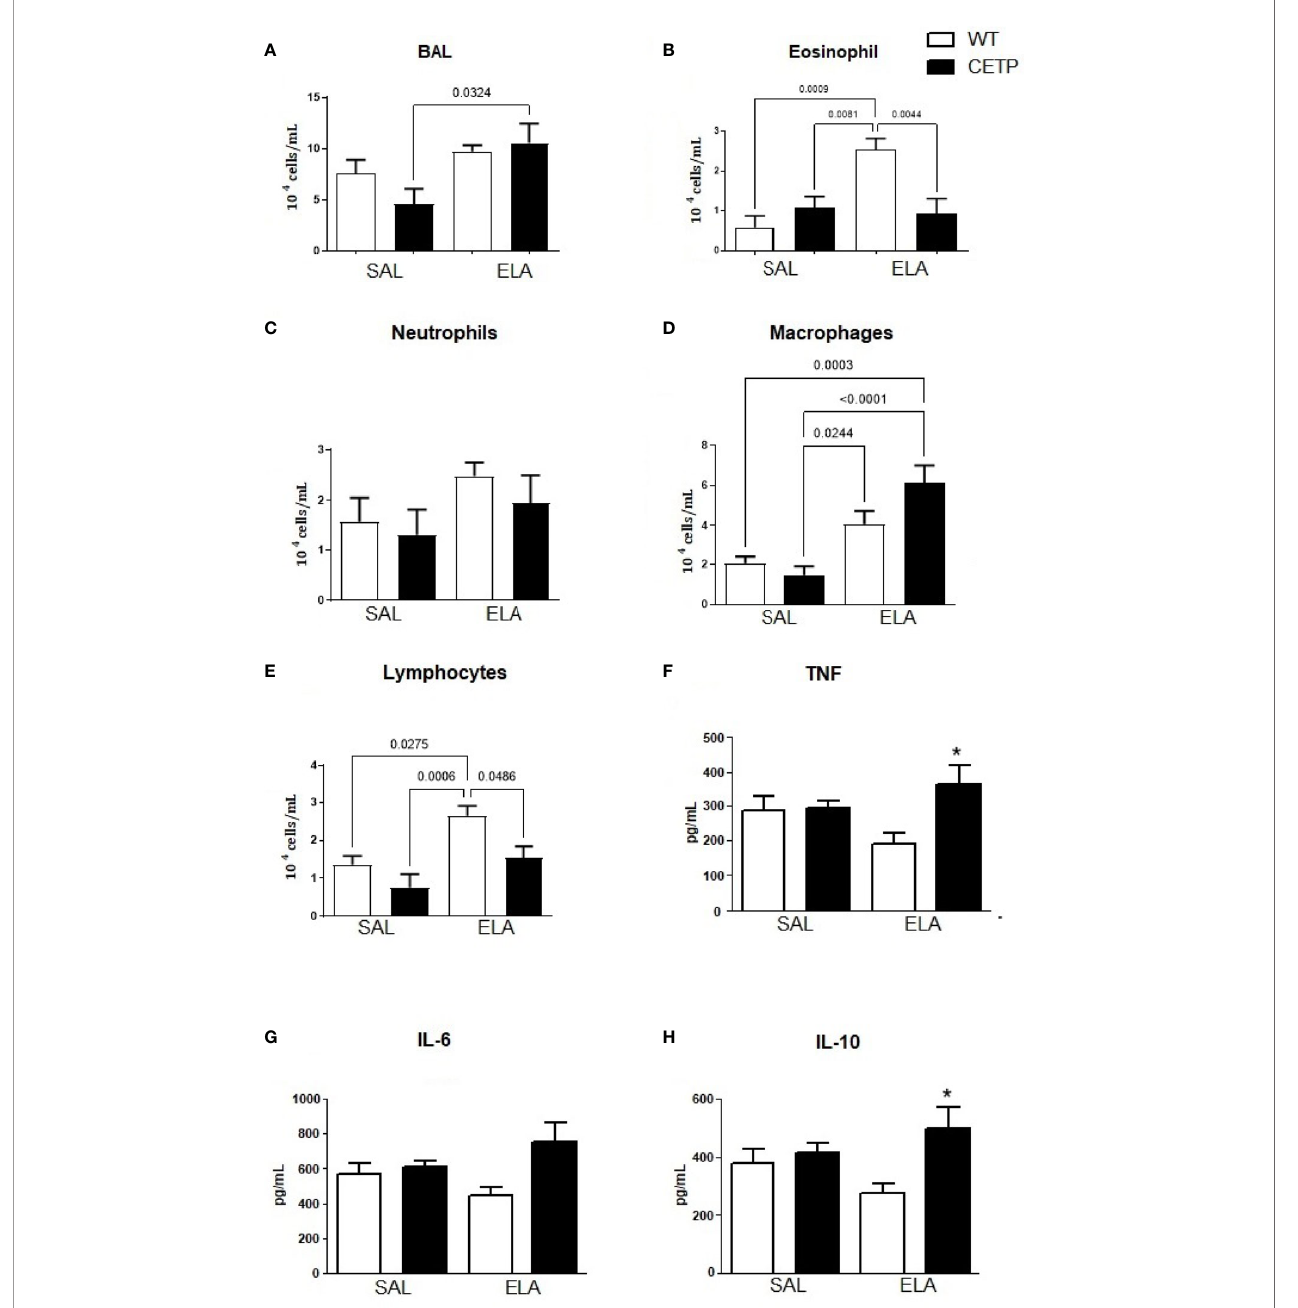
FIGURE 10 | Total and differential leukocyte count in broncho-alveolar lavage (BAL), and cytokine levels in WT and huCETP mice after elastase-induced emphysema (ELA) or saline (SAL). Total cells (A) , eosinophils (B) , neutrophils (C) , macrophages (D) , lymphocytes (E) , cytokines in BAL: TNF (F) , IL-6 (G) , IL-10 (H) , cytokine plasma (I) . Values were expressed as mean and standard deviation. These data were analyzed by ANOVA with two-stage linear step-up procedure of Benjamini, Krieger, and Yekutieli post-test. P < 0.01: *CETP Ela vs . all groups, (n =